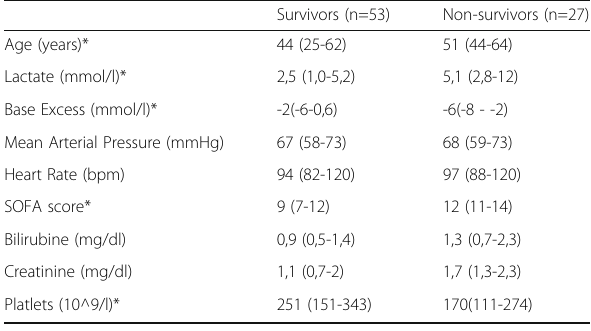
Table 66 (abstract A193). Table 67 (abstract A194). Thrombolysis and Mortality in STEMI